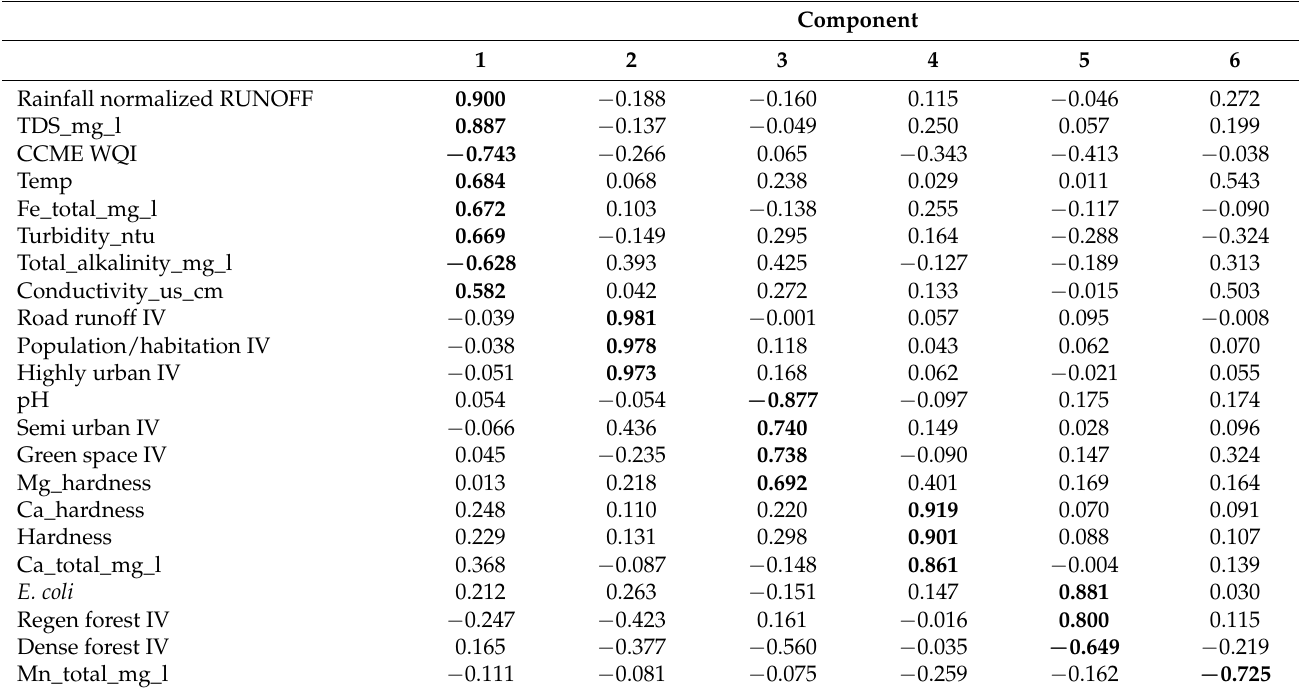
Table 3. Rotated component matrix showing factor loadings of 22 WQ and land-use variables on the extracted PCA components/factors. Rotated Component